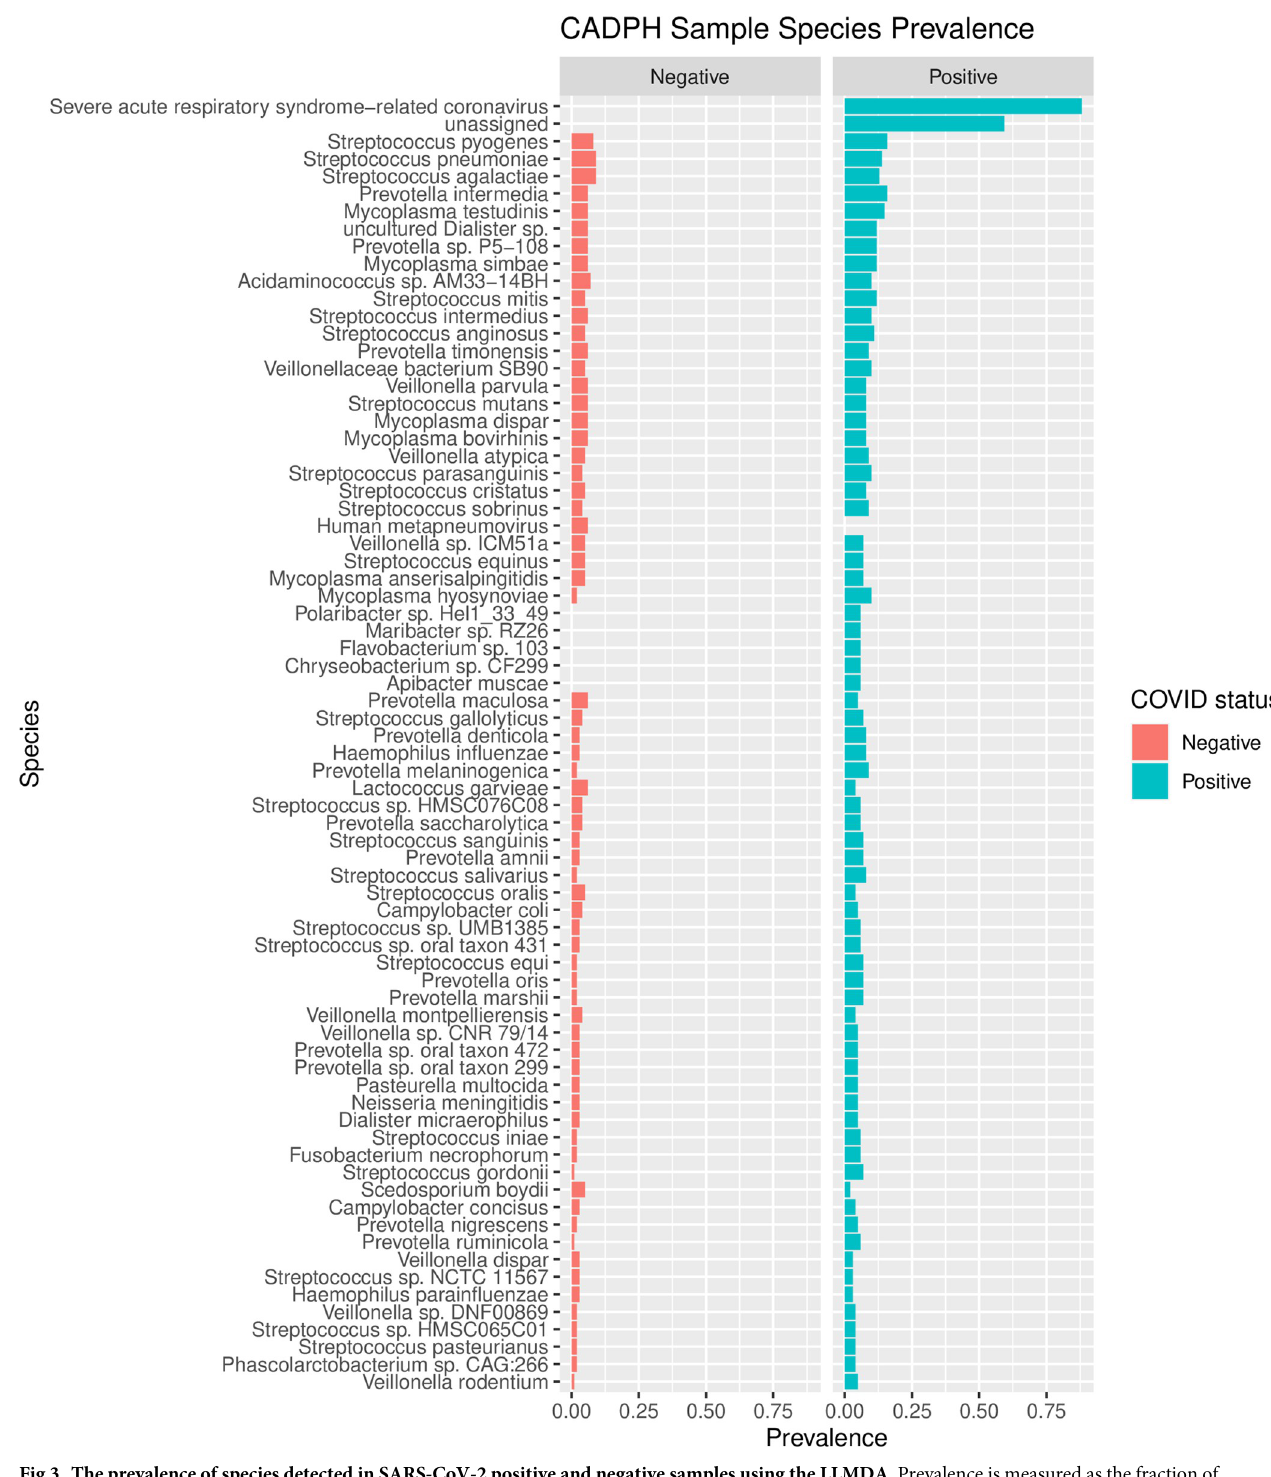
Fig 3. The prevalence of species detected in SARS-CoV-2 positive and negative samples using the LLMDA. Prevalence is measured as the fraction of samples in which the taxon was found. Species with a prevalence less than 5% across all samples are not shown.